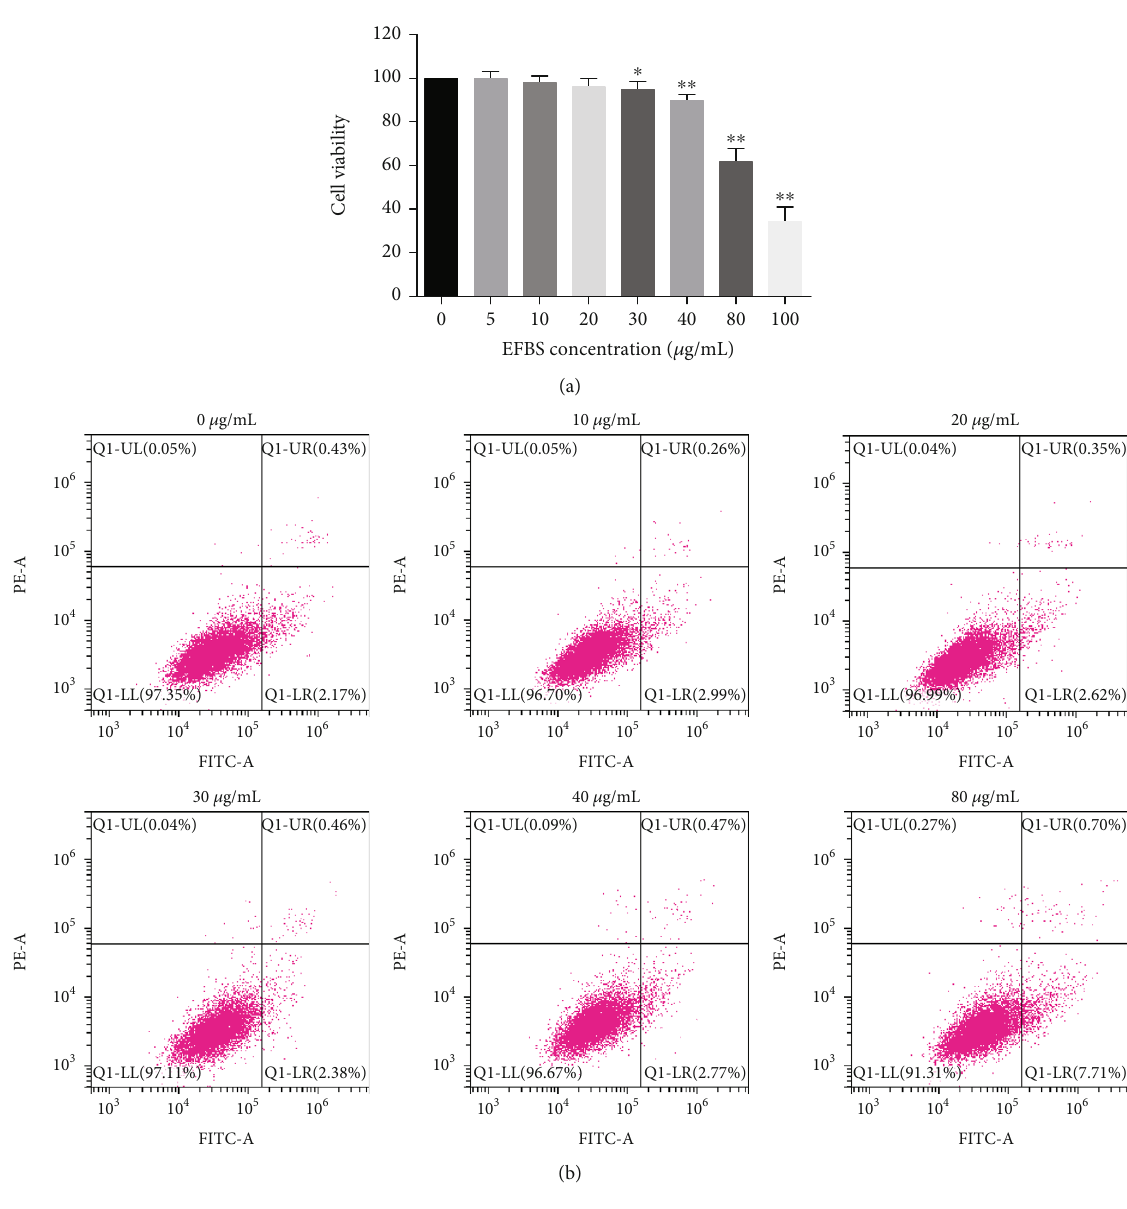
Figure 6: Cell viability (a) and cell apoptosis (b) treated by di ff erent concentrations of EFBS. Statistical analysis was performed using one-way ANOVA followed by the Tukey-Kramer posttest. ∗ P < 0 : 05 , ∗∗ P < 0 : 01 compared with vehicle treatment